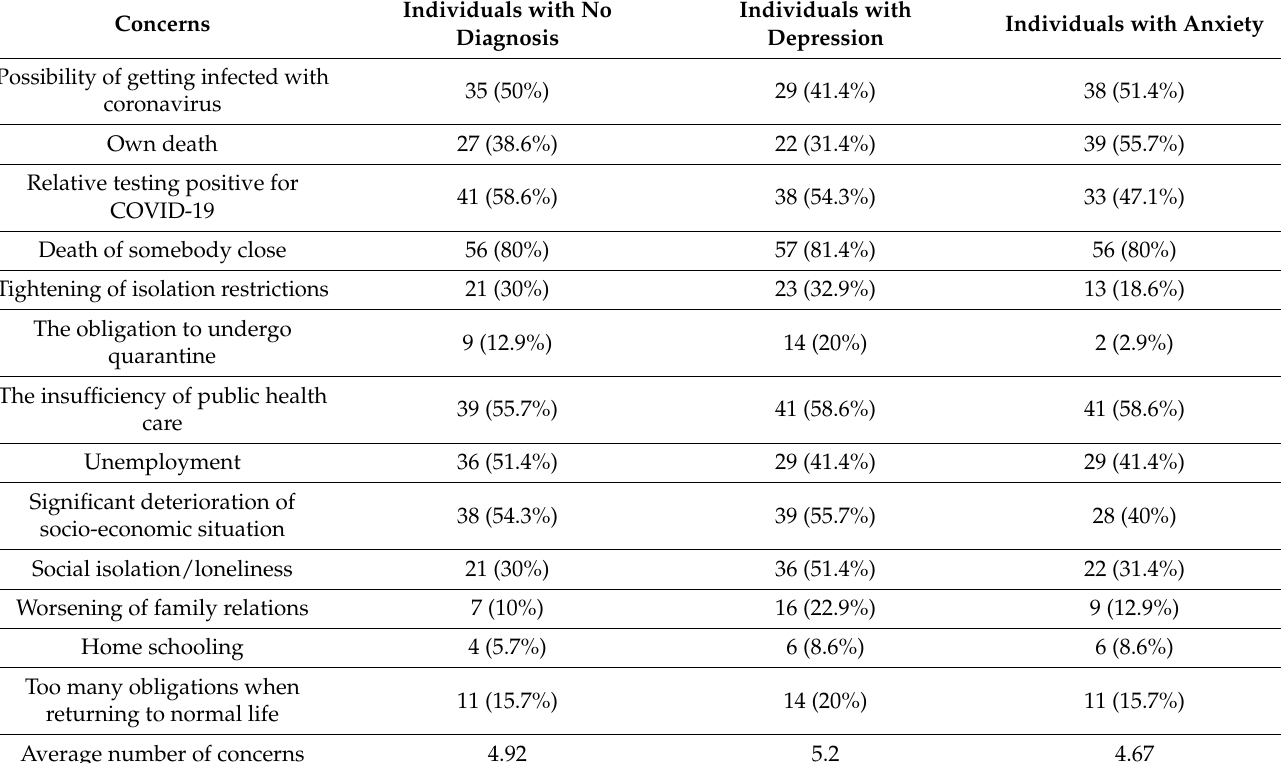
Table 2. Concerns in each group.